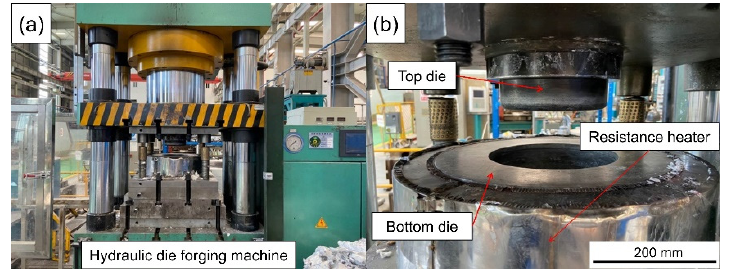
Figure 6. Physical diagram of hydraulic die forging machine ( a ) and die assembly ( b ).